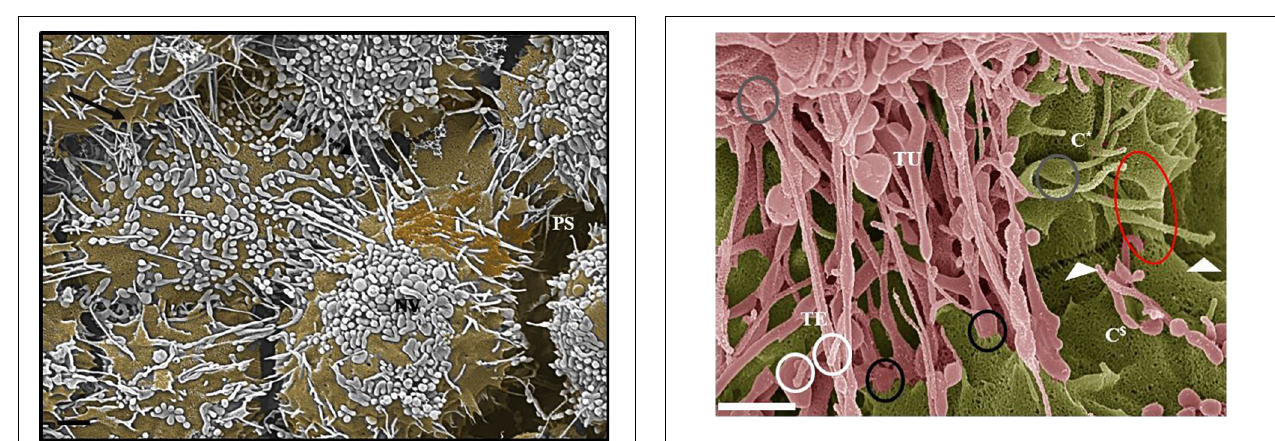
FIGURE 5 | An HRSEM micrograph 24 h after seeding b.End5 (BECs) in close proximity (1 × 10 6 cells/insert/well) (Scale bar = 1000 nm). The nanovesicle is denoted by an “ NV, ” TUNTs are indicated by the perforated, black arrow and TENT formation is indicated by the solid, black arrow and the “ PS, ” denotes the PC space.